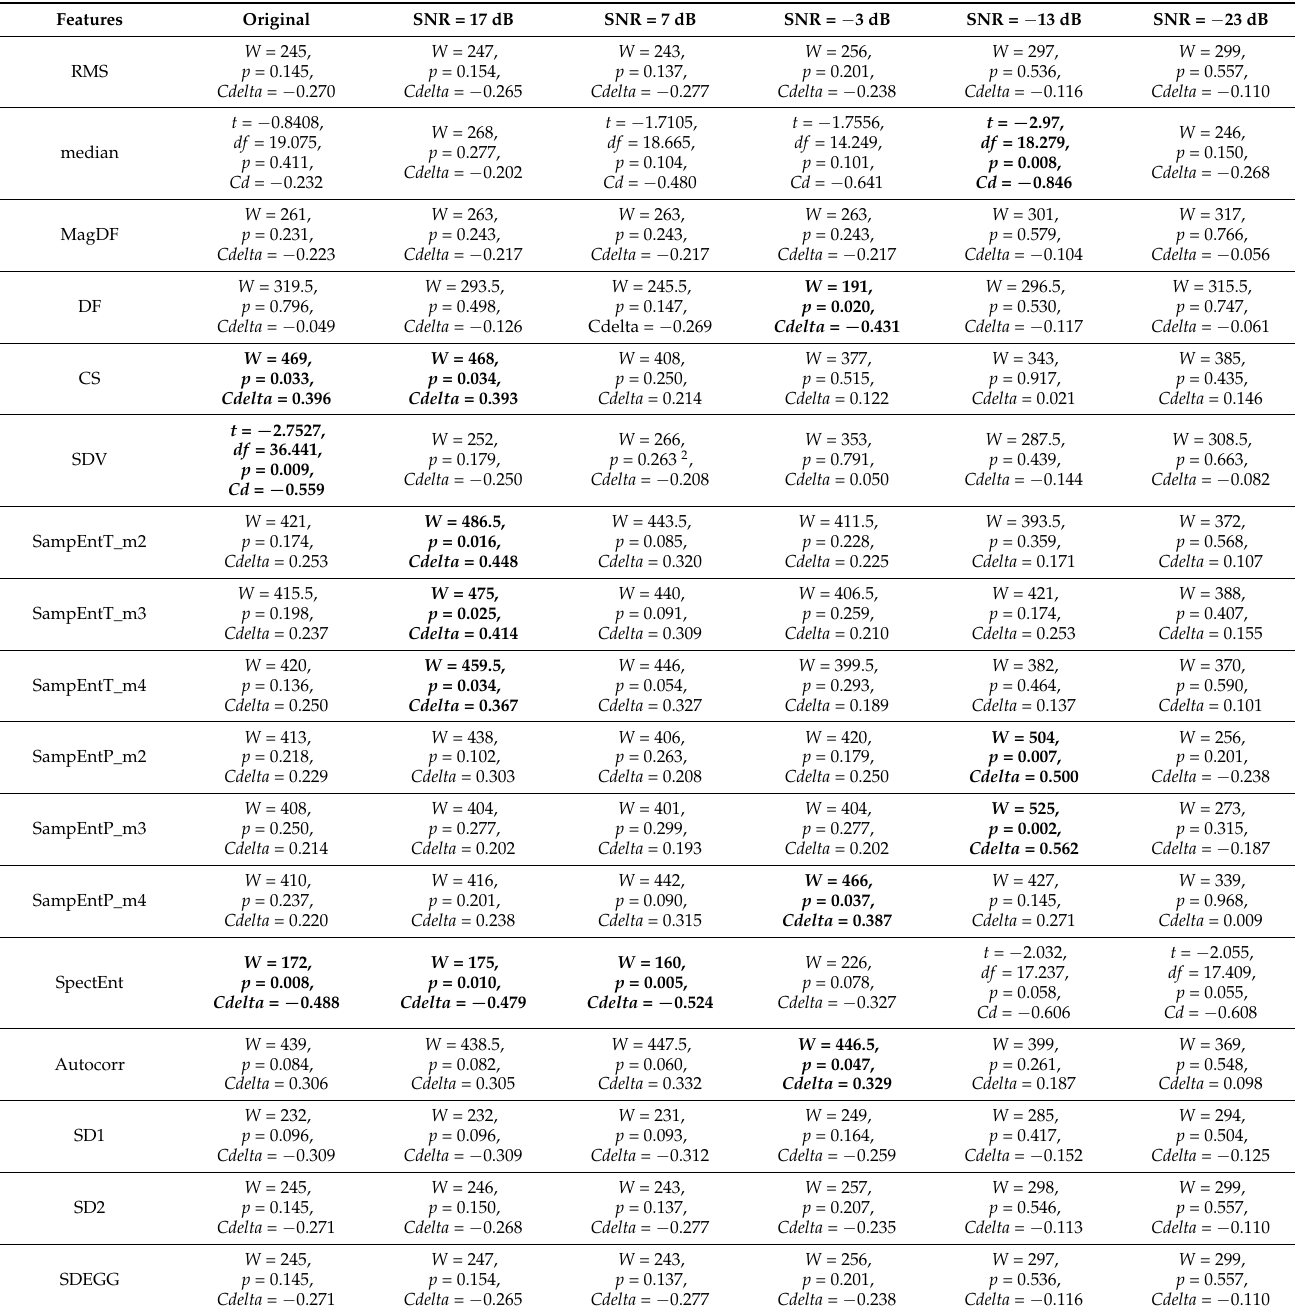
Table 5. Results of statistical tests for the comparison of parameters with and without nausea for non-noisy and noisy data with different noise levels. For testing normality, p is set at 0.05. Statistically significant differences are presented in bold ( p < 0.05). SNR stands for Signal-to-Noise Ratio, W stands for W-statistics, p for probability, Cdelta for Cliff’s delta , Cd for Cohen’s d , t for t-statistics, and df for degrees of